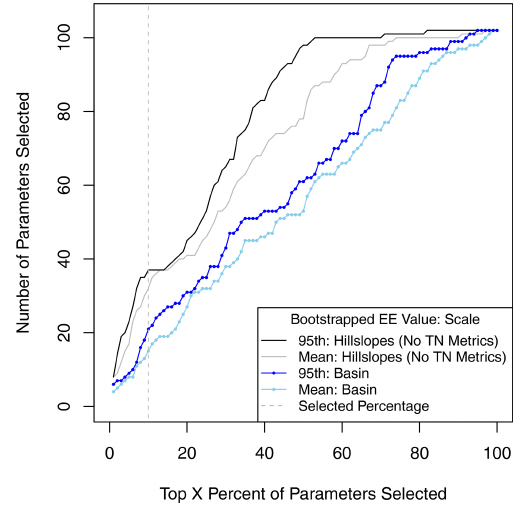
Figure 2. The number of parameters that would be selected for model calibration using the decision-relevant sensitivity metrics as a function of the cutoff percentage used to select parameters based on their elementary effects. The blue lines with circle points indicate the parameters that would be selected using only the basin outlet, while the gray lines correspond to using all hillslope outlets. Only streamflow metrics are considered for the hillslope outlets. Lighter line colors correspond to the bootstrapped mean and darker colors correspond to using the bootstrapped 95th percentiles of the elemen- tary effects to select parameters. The vertical dashed line indicates the selected 10% cutoff used as an example in this